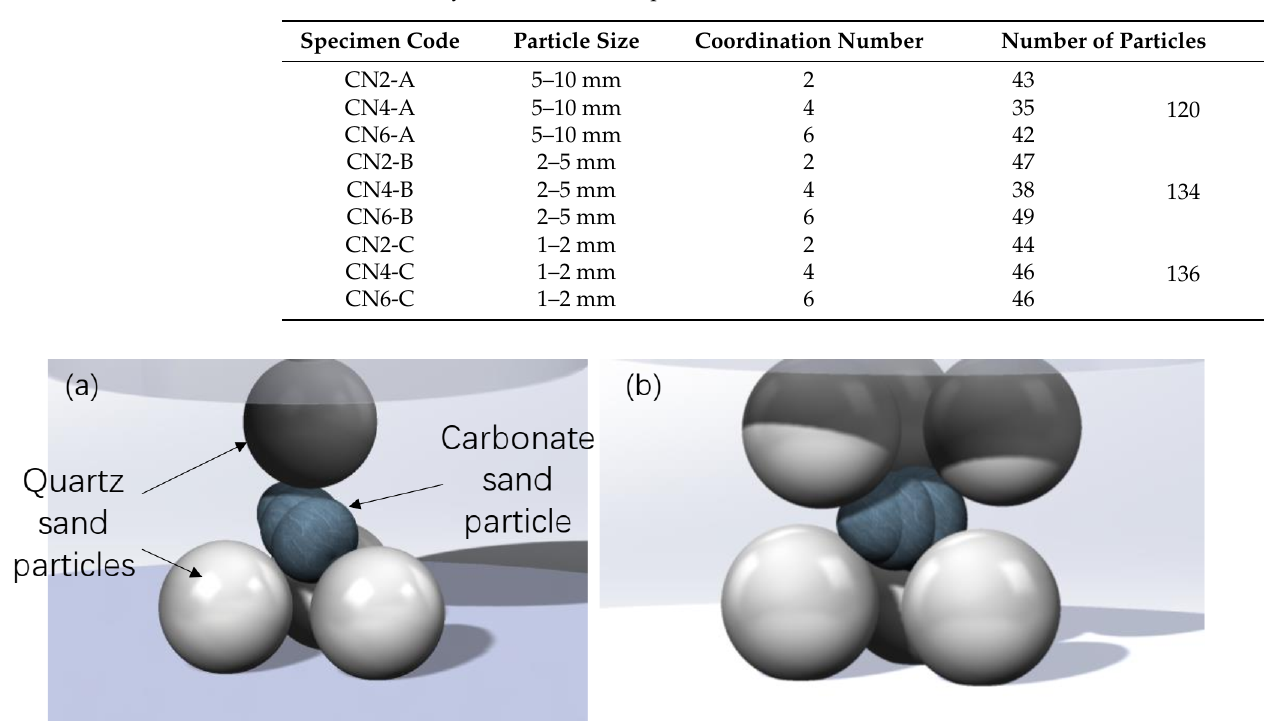
Table 1. Summary of carbonate sand particles tested.